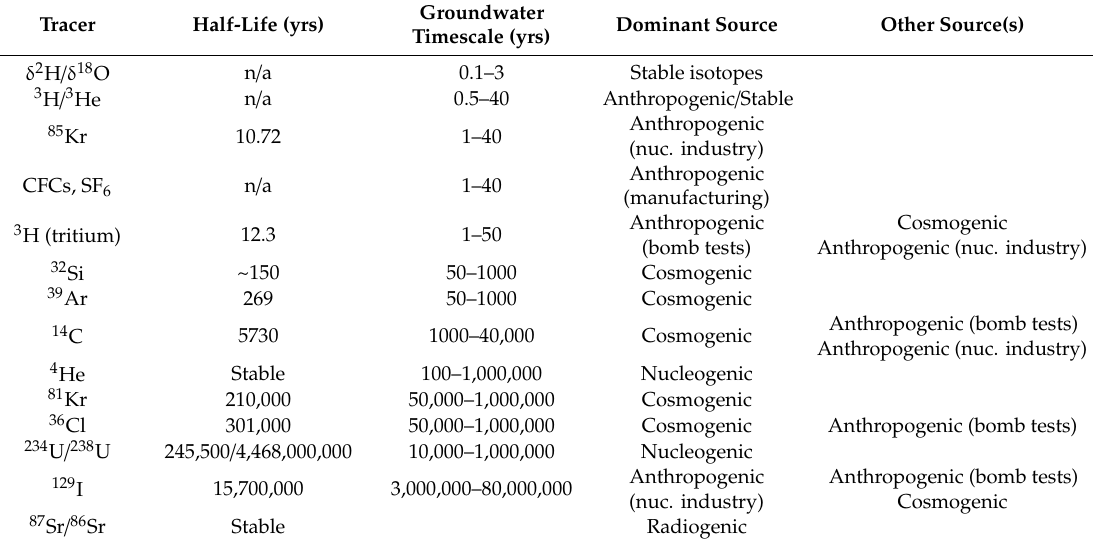
Table 1. Selected environmental